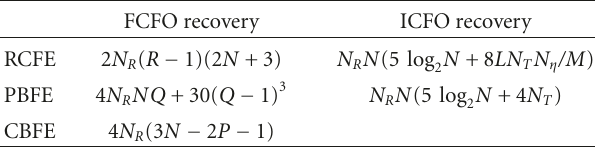
Table 1: Complexity of FCFO and ICFO estimation schemes. FCFO recovery ICFO recovery